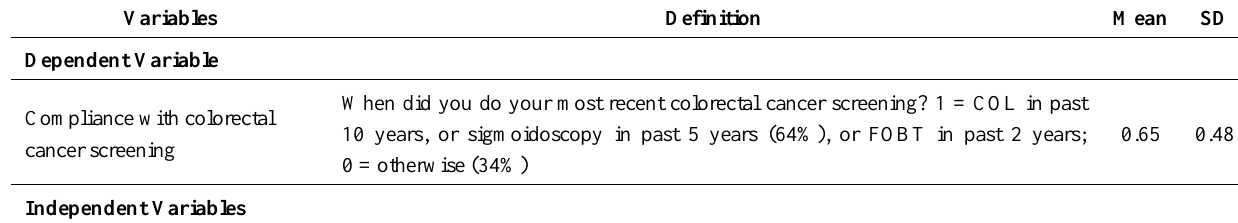
Table 1. Definition and characteristics of CRC related health information (observations =